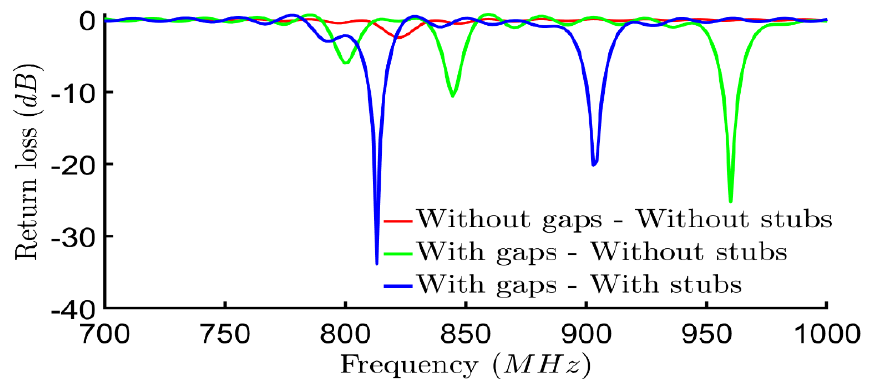
Figure 7. The return loss of the proposed structure vs. different configuration: without stubs without gaps; without stubs with gaps; with stubs with gaps.